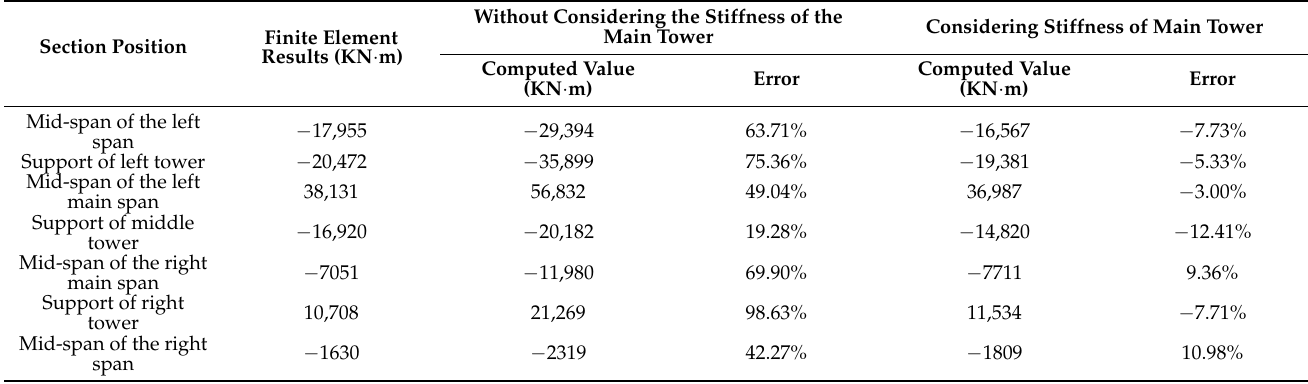
Table 2. The bending moment of control section of stiffening beam under live load in the middle section of left main span.